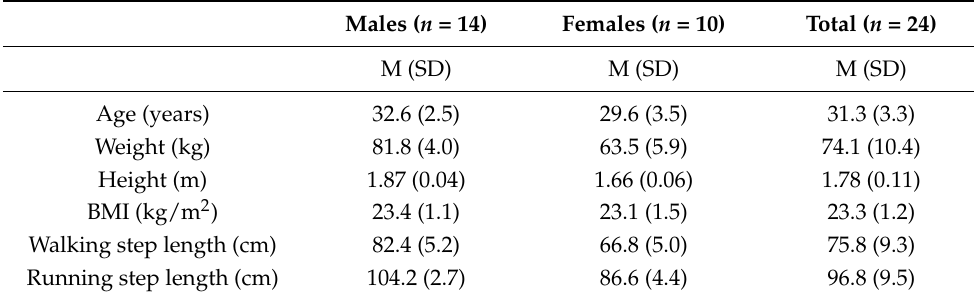
Table 1. Participants’ characteristics (Mean ±